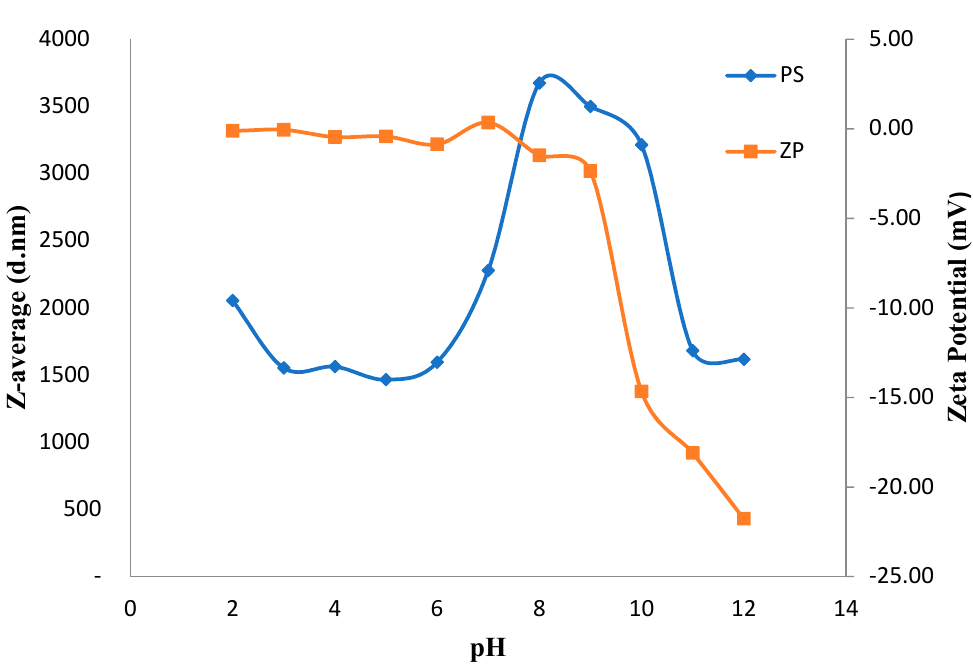
Figure 4. Effect of pH on the zeta potential values of LSP.